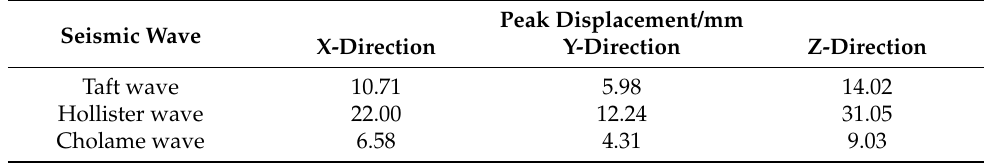
Table 10. Peak displacement of center-hung